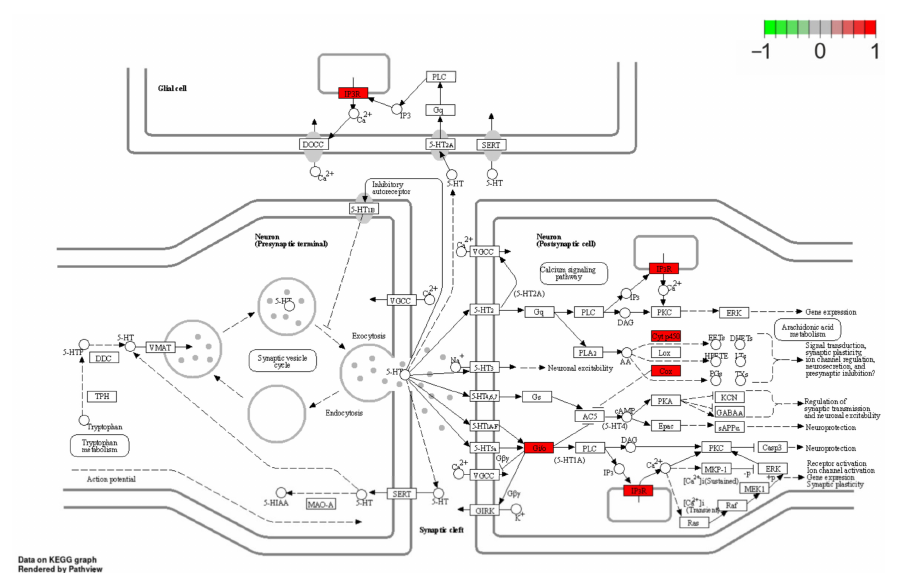
Figure 4. Enrichment Kyoto Encyclopedia of Genes and Genomes (KEGG) analysis of differentially expressed genes (DEGs) engaged in ‘Serotonergic synapse’. Red rectangles represent upregulated genes. Logarithmic fold change (logFC; red–green scale) describes gene expression